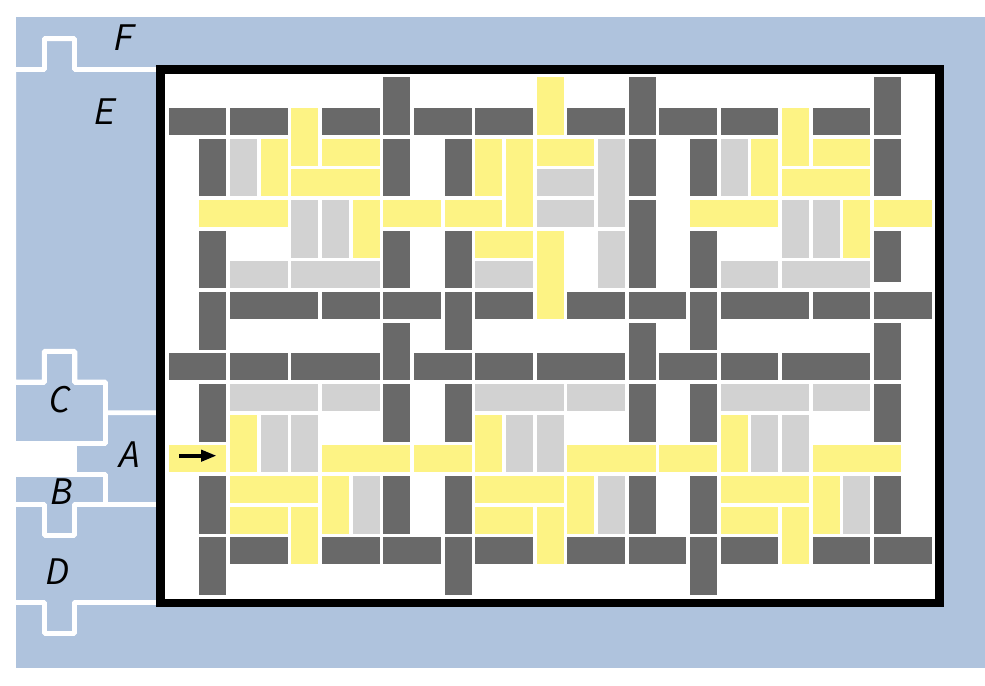
Figure 9. An exploding sliding block